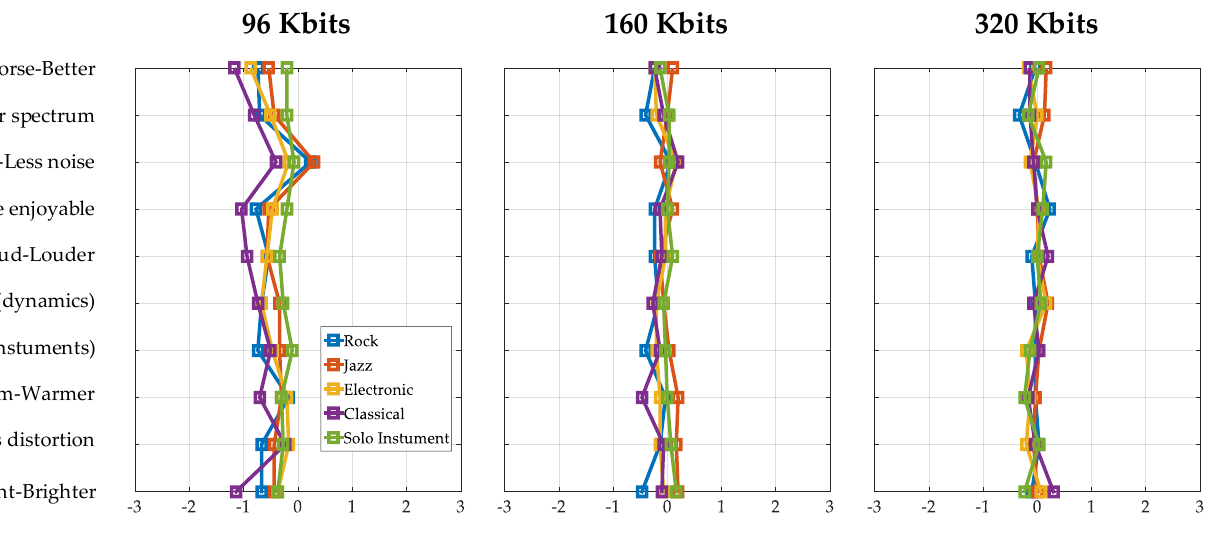
Figure 3. Average evaluation scores for the bipolar scales for different bitrates.